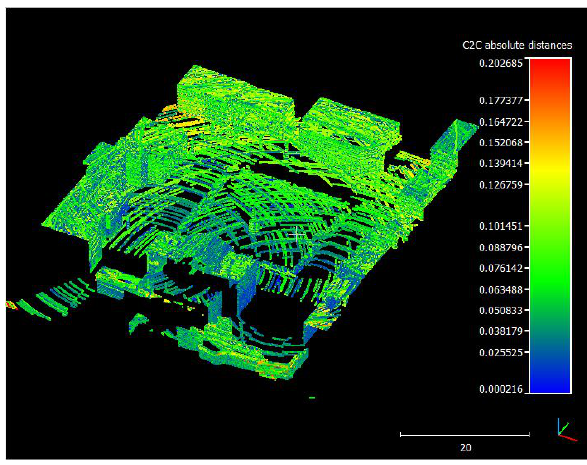
Figure 5: Simulated lidar points errors